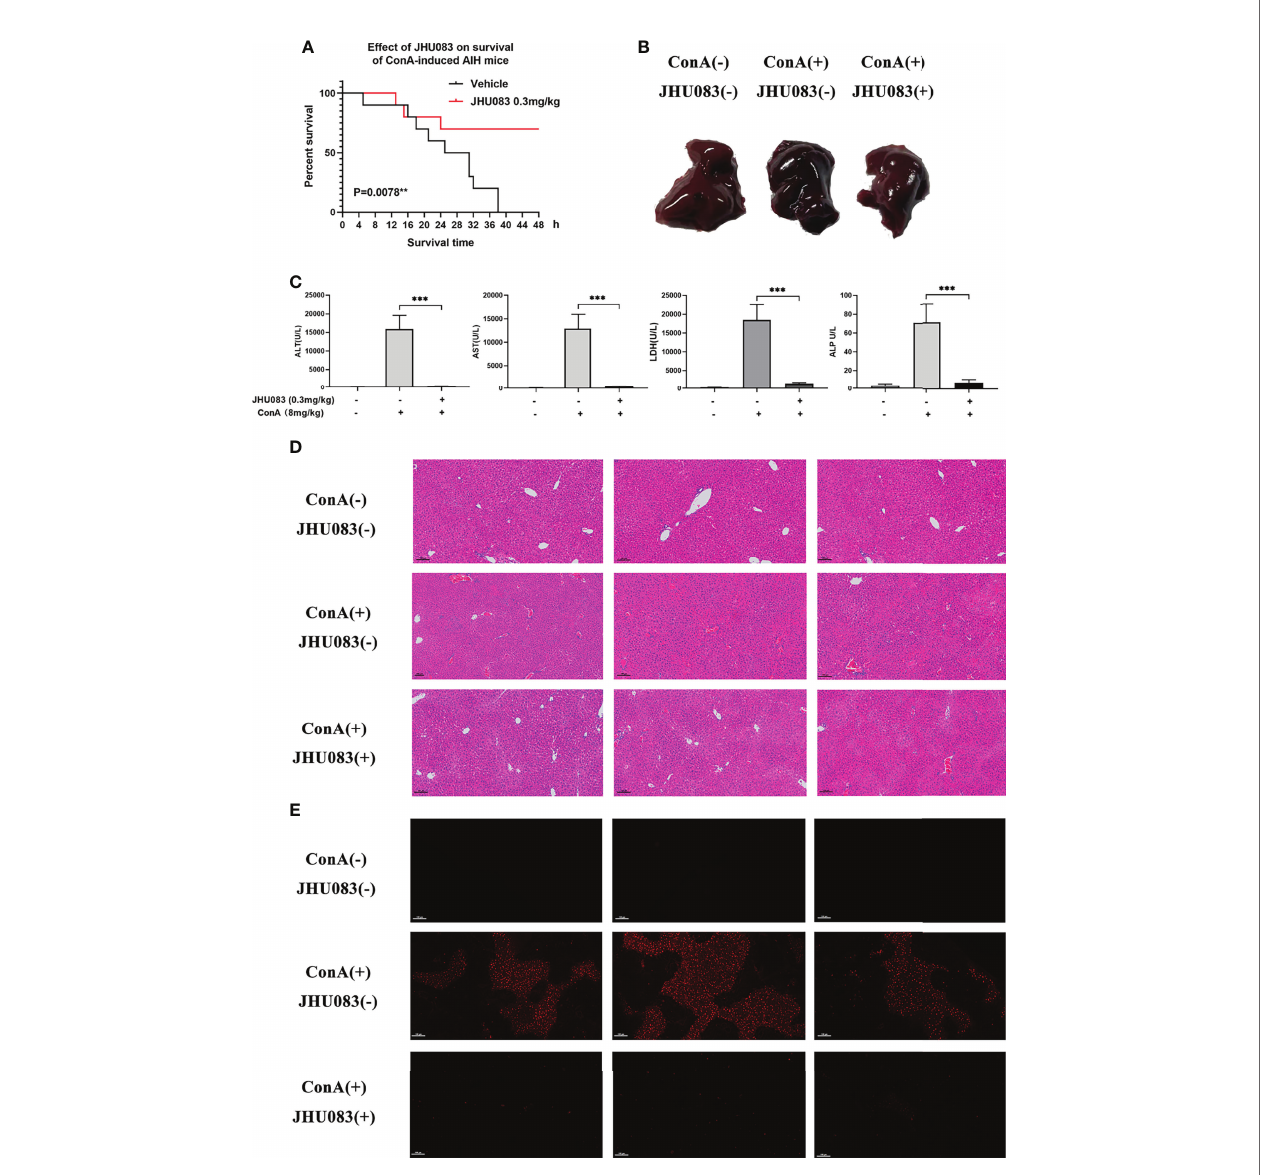
FIGURE 1 | JHU083 attenuated ConA-induced AIH. (A) . Survival of 20ml/kg ConA-induced autoimmune hepatitis mice gavaged with vehicle or 0.3mg/kg JHU083 24h and 1h before ConA injection. n = 10. (B – E) Mice of Vehicle-AIH and JHU083-AIH group were intravenously injected with 8 mg/kg ConA, and mice of Vehicle- WT group were injected with normal saline of equal volume. Mice of JHU083 group were gavaged with 0.3mg/kg JHU083 24h and 1h before ConA injection, and WT and vehicle group were treated with equal vehicle at the same time points. Representative macroscopic images of livers (B) , quanti fi cation of serum ALT, AST, LDH and ALP (C) , H&E staining (D) and TUNEL assay (E) were presented 6h after ConA injection. The scale bar for H&E staining and TUNEL assay is 100 m m. Red fl uorescence in TUNEL assay indicates positive signals of apoptosis. Data were expressed as means ± SEM. ** P <0.01 and *** P